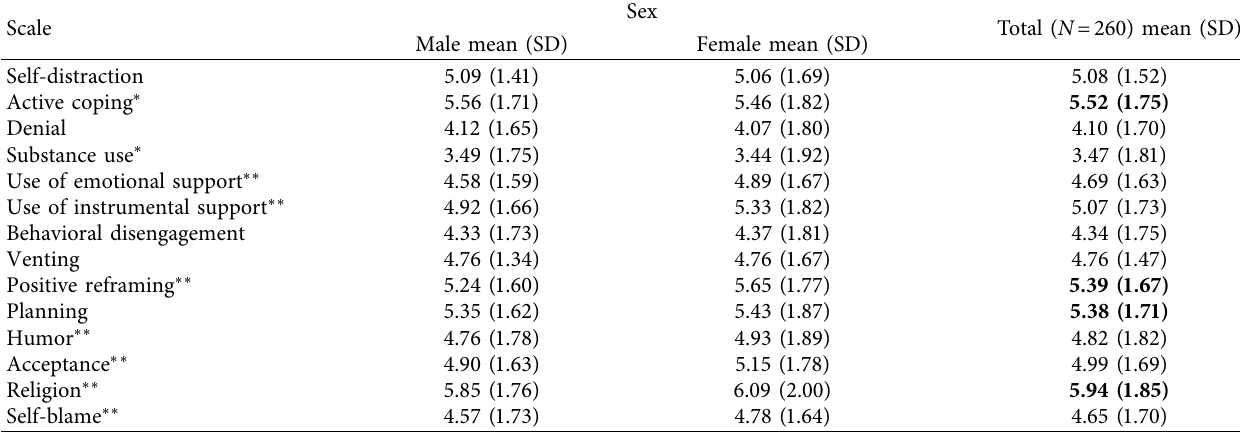
Table 3: Rank of coping strategies according to mean score as rated by study participants in relation to gender, N � 260, AU, January 2019.